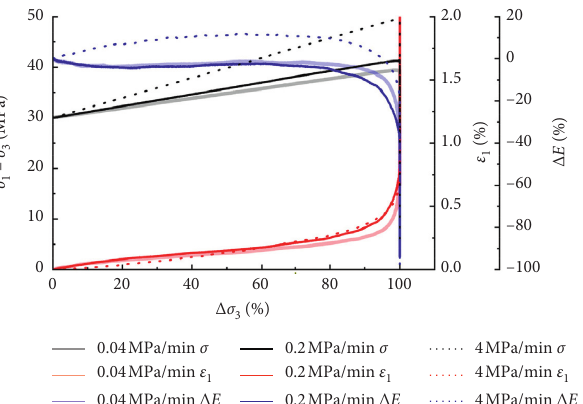
Figure 12: The relationship curve between Δ σ